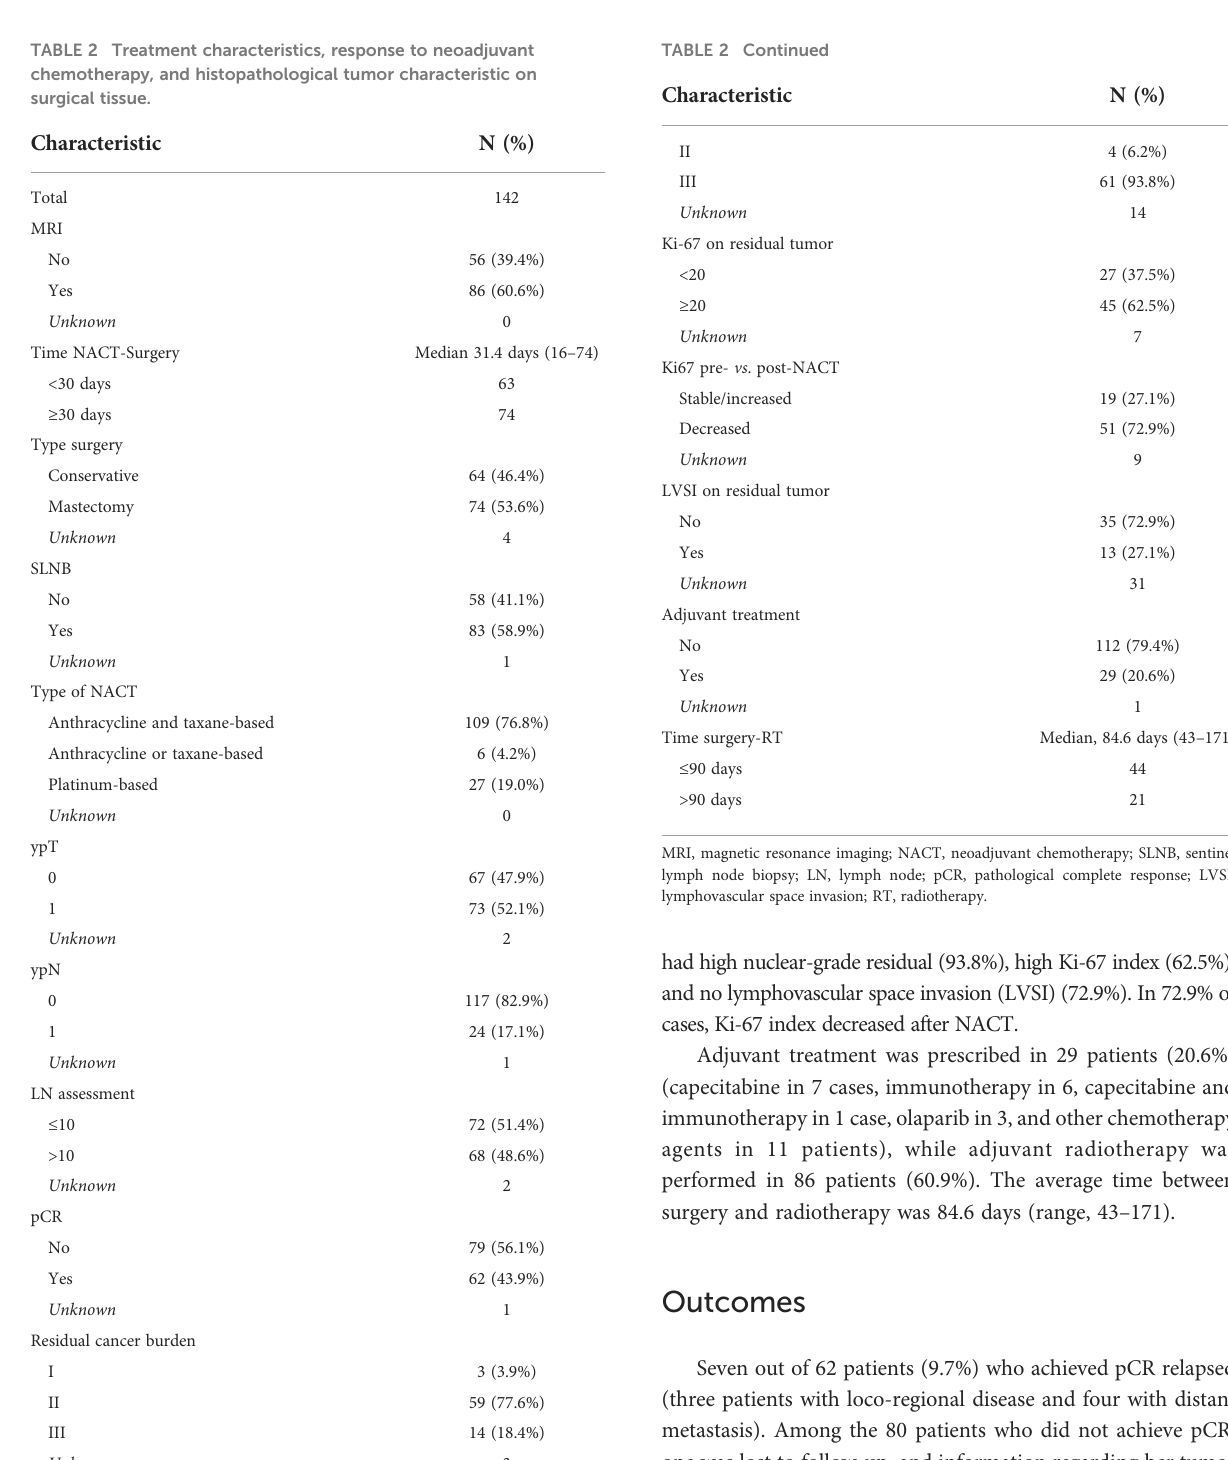
residual and outcome are is available. On the other hand, 23 out